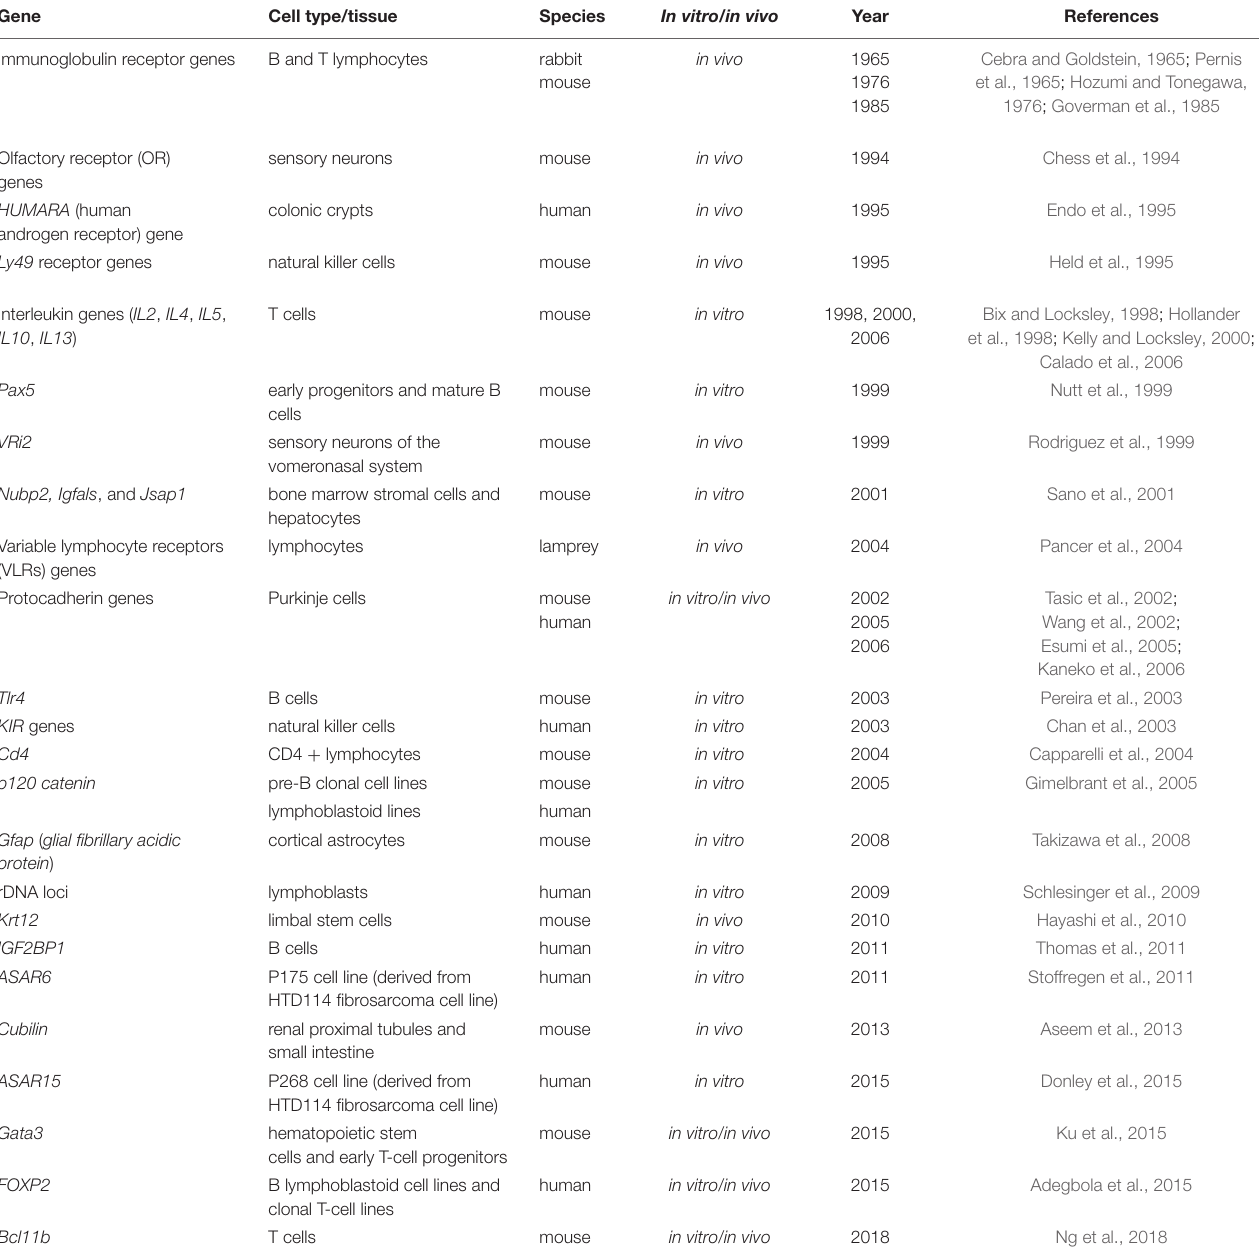
TABLE 1 | List of autosomal genes under random monoallelic expression reported in studies focused on single genes.